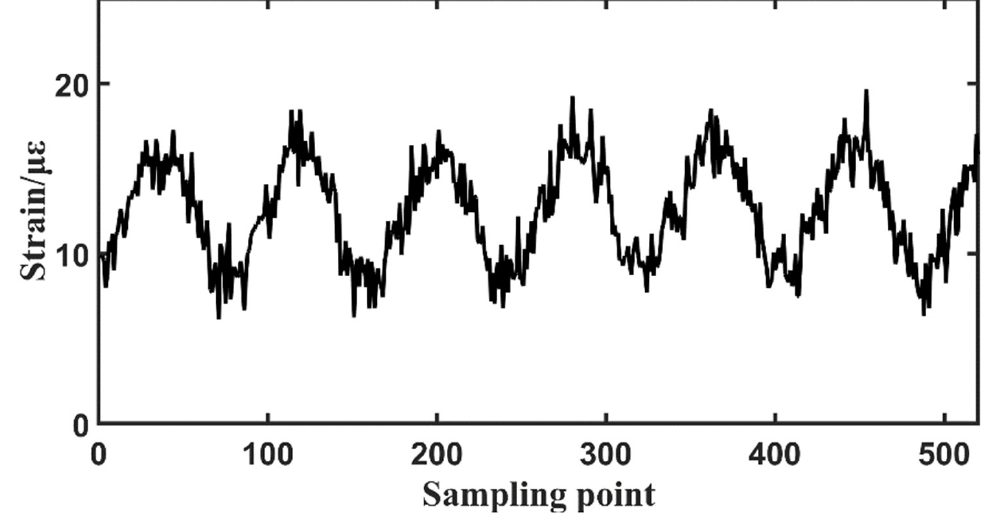
Figure 8. Time-domain noise signal.